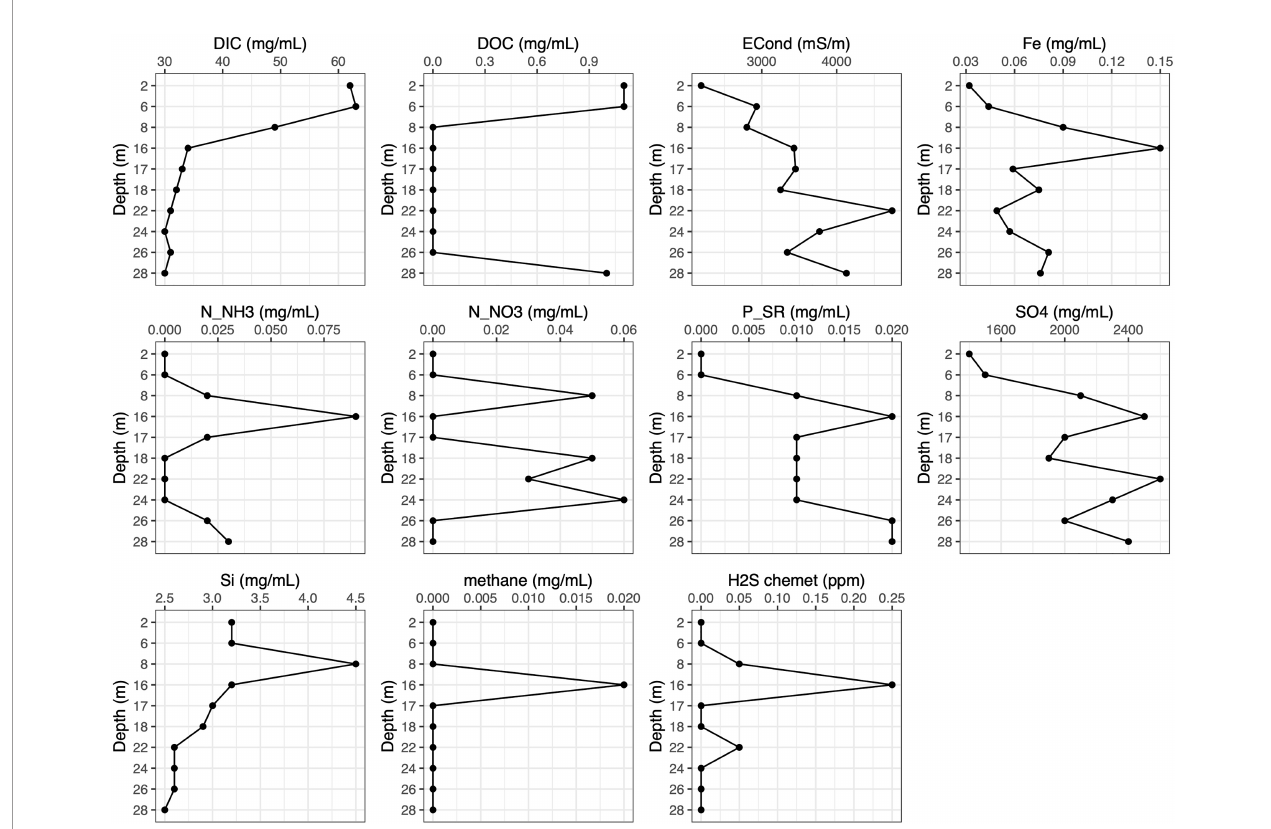
FIGURE 2 | Physicochemical data plots for samples taken in parallel to microbial sample collection. DIC, dissolved inorganic carbon; DOC, dissolved organic carbon; ECond, Electrical conductivity; Fe, total iron; N_NH3 – NH 3, nitrogen available as ammonia; N_NO3 – NO − 3 , nitrogen available as nitrate; P_SR, phosphate soluble reactive; SO4, SO 4 , sulphate; Si, silicon; methane, CH 4 , H2S – H 2 S, hydrogen